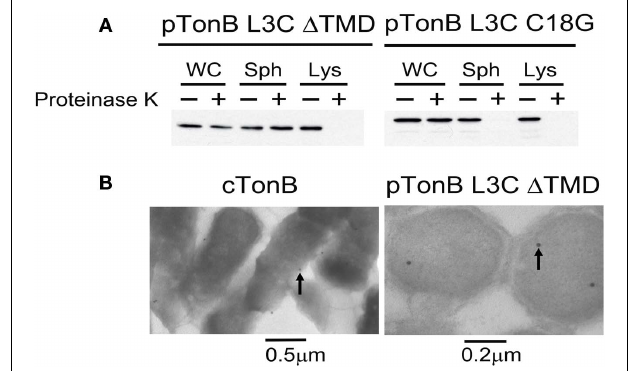
FIGURE 5 |TonB L3C Δ TMD is cytoplasmically localized. (A) TonB L3C Δ TMD is resistant to proteinase K in intact spheroplasts but sensitive to proteinase K in lysed spheroplasts. Strains pTonB L3C Δ TMD (KP1440 ( Δ tonB , exbB ::Tn10, tolQ am )/pKP544) and pTonB L3C C18G (KP1440/pKP478) were converted to either intact or lysed spheroplasts and treated with or without proteinase K as described in Section “Materials and